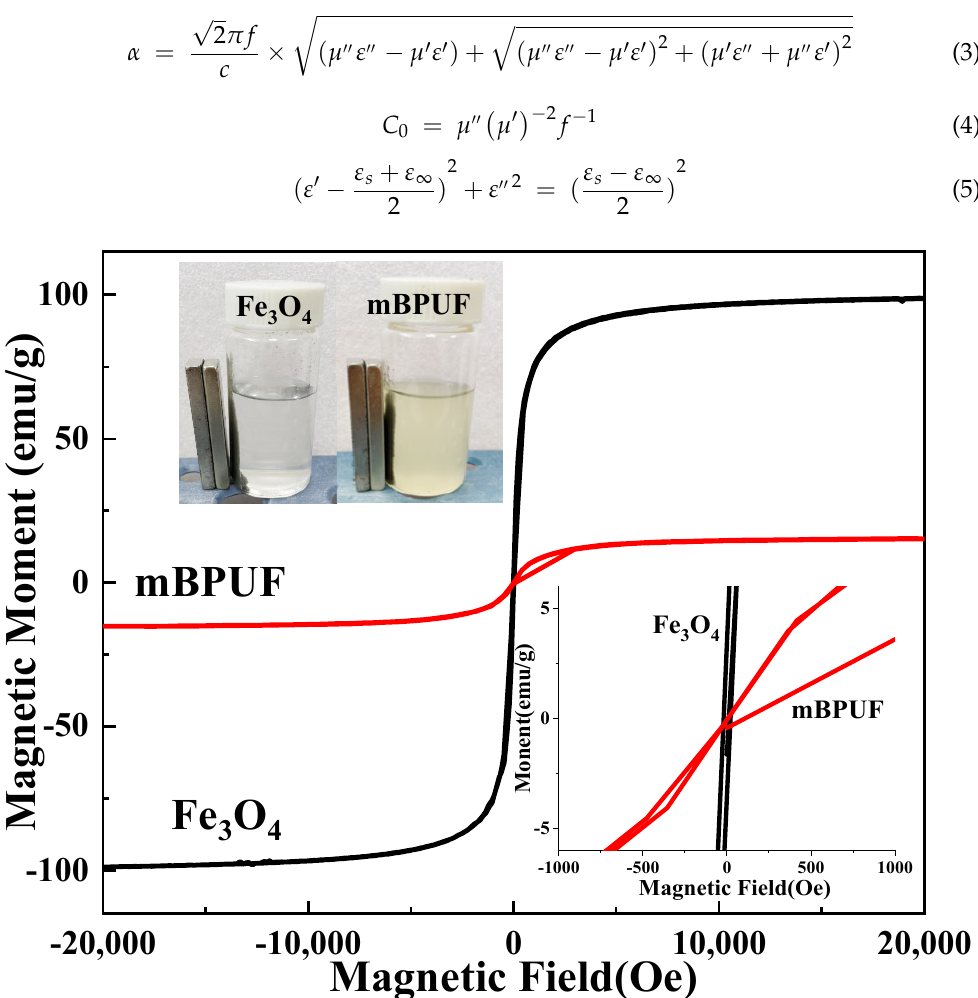
Figure 5. Saturation magnetization curves of Fe 3 O 4 and mBPUF composite.